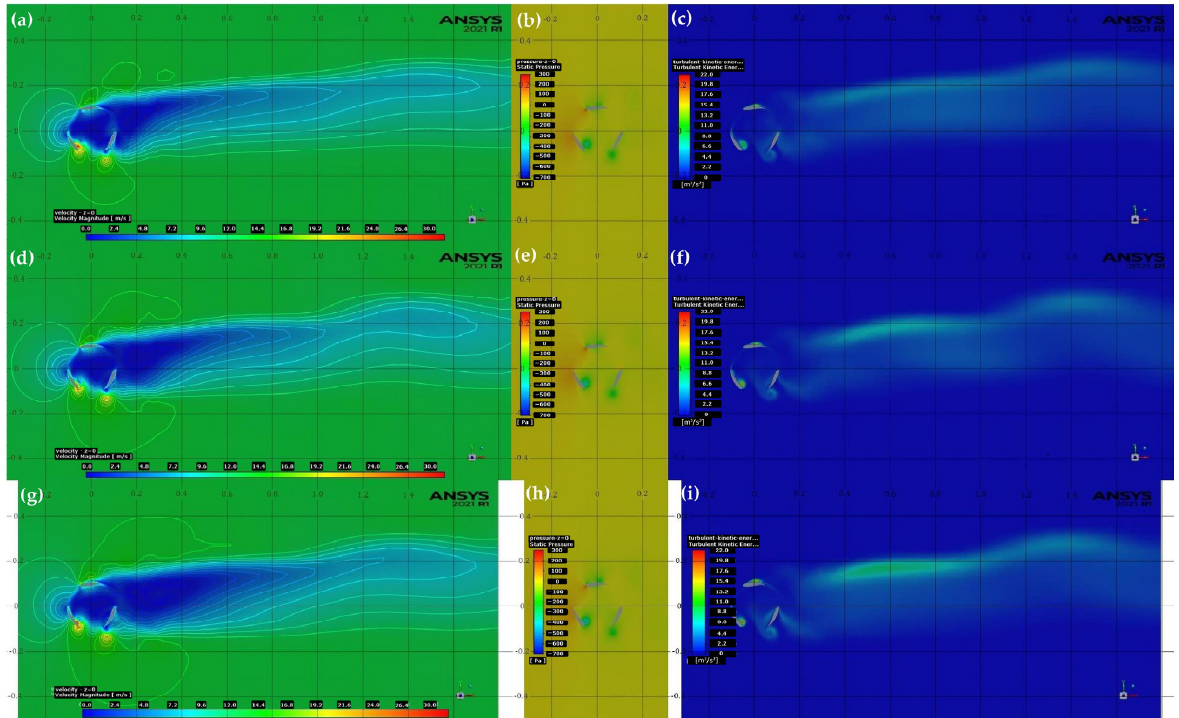
Figure 14. Contours at wind speed 14 m/s, rotational speed 98 rad/s for varied blade lengths/heights: ( a ) Velocity at 0.15 m; ( b ) Pressure at 0.15 m; ( c ) TKE at 0.15 m; ( d ) Velocity at 0.20 m; ( e ) Pressure at 0.20 m; ( f ) TKE at 0.20 m; ( g ) Velocity at 0.25 m; ( h ) Pressure at 0.25 m; ( i ) TKE at 0.25